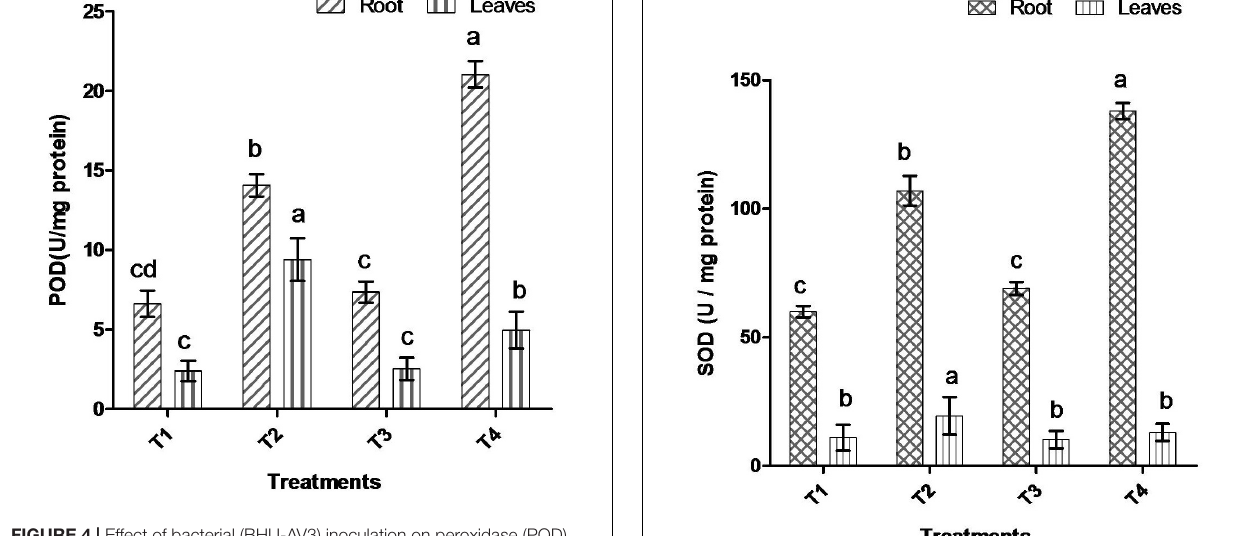
FIGURE 4 | Effect of bacterial (BHU-AV3) inoculation on peroxidase (POD) activity in root and leaves under salt stress. T1 – control, T2 – salt (NaCl), T3 – bacterial (BHU-AV3) inoculation, and T4 – bacterial inoculation + salt. Values represent the mean ± SD, n = 3. Different letters on each bar indicate significant differences ( P = 0.05) after DMRT test.